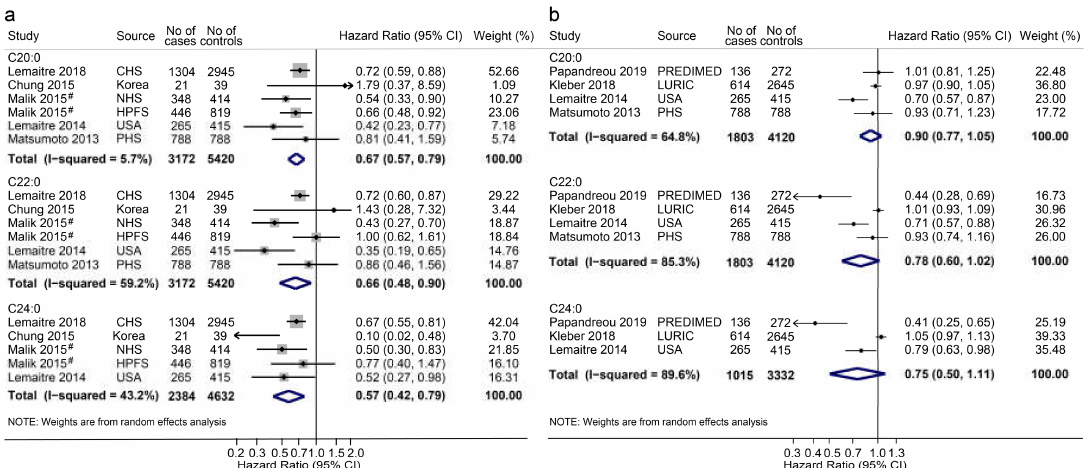
Figure 2. Forest plot of studies investigating the associations between blood very-long-chain fatty acids (VLCSFAs) proportion and cardiovascular diseases. ( a ) Combined hazard ratios (HRs) for the comparison of the highest quantile with the lowest quantile; ( b ) Pooled HRs for per standard deviation (SD) increase. Abbreviations: CI, confidence interval; CHS, the Cardiovascular Health Study; NHS,theNurses’HealthStudy; HPFS,theHealthProfessionalsFollow-UpStudy; USA,theUnitedStates of America; PHS, the Physicians’ Health Study; PREDIMED, the Prevenci ó n con Dieta Mediterr á nea trial; LURIC, the Ludwigshafen Risk and Cardiovascular Health study. # Malik (2015): we used the pooled hazard ratios for the association between plasma and erythrocyte VLCSFA proportions and coronary heart diseases from NHS and HPFS cohort reported in 2015 by